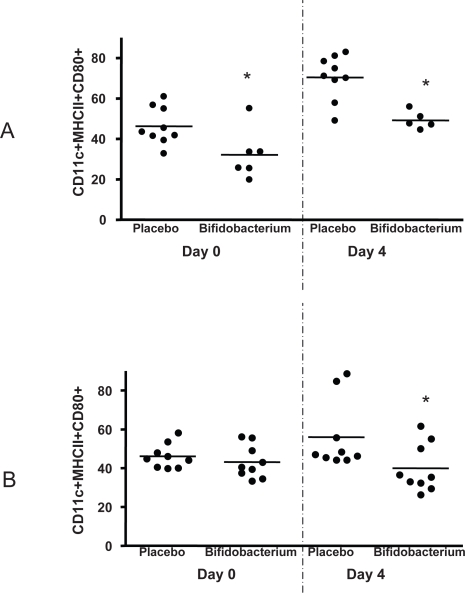
Dendritic cells are less activated in B. infantis-fed mice.(A) The percentage of CD11c+MHC II+ mature dendritic cells staining positive for the co-stimulatory molecule CD80 are reduced in the Peyer's patch of B. infantis-fed mice prior to and during S. typhimurium infection. (B) Splenocyte dendritic cell CD80 expression is similar in both groups of un-infected mice but is significantly up-regulated with Salmonella infection only in the placebo group. *p<0.05 versus placebo, n = 6–9 animals per group per timepoint.